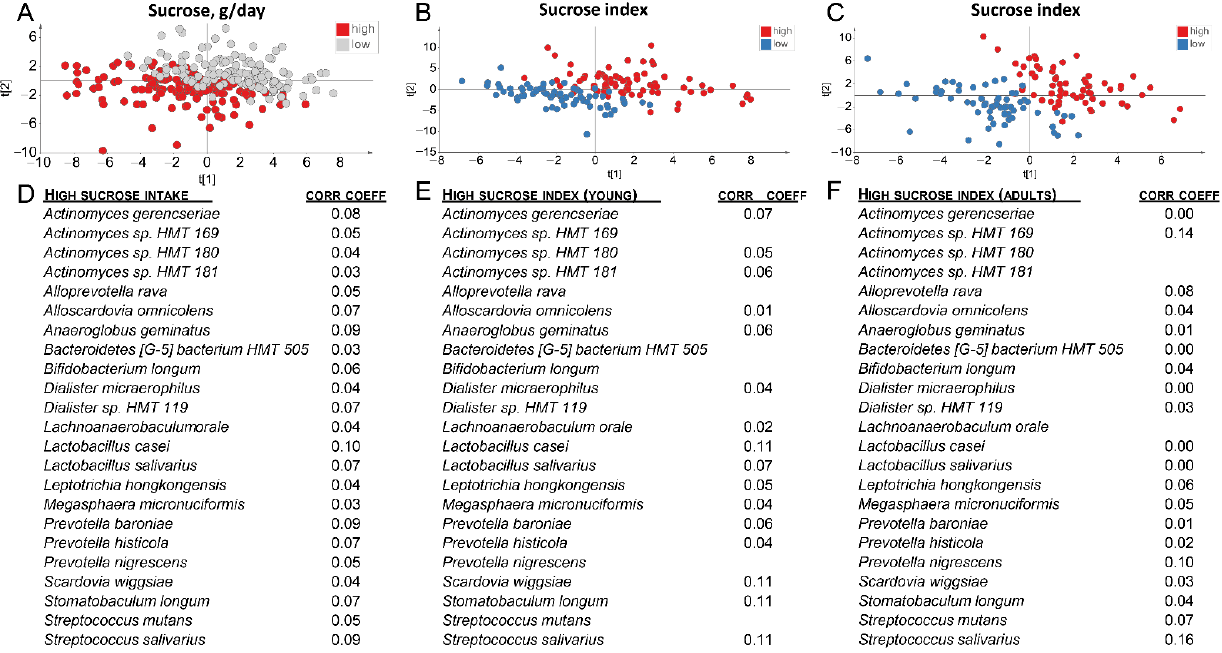
Table 2. Characteristics of the participants in the replication cohort.